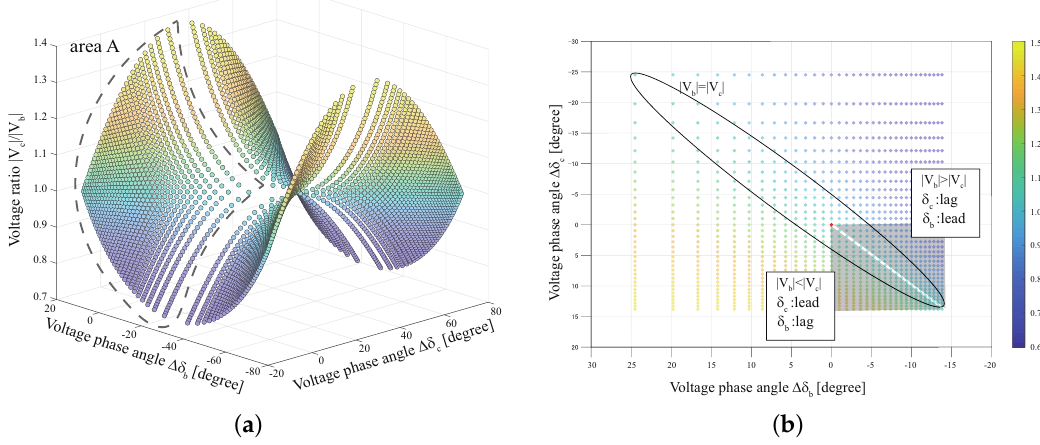
Figure 10. Undetectable unbalance points on the d–q transformation: ( a ) 3D plot and ( b ) 2D